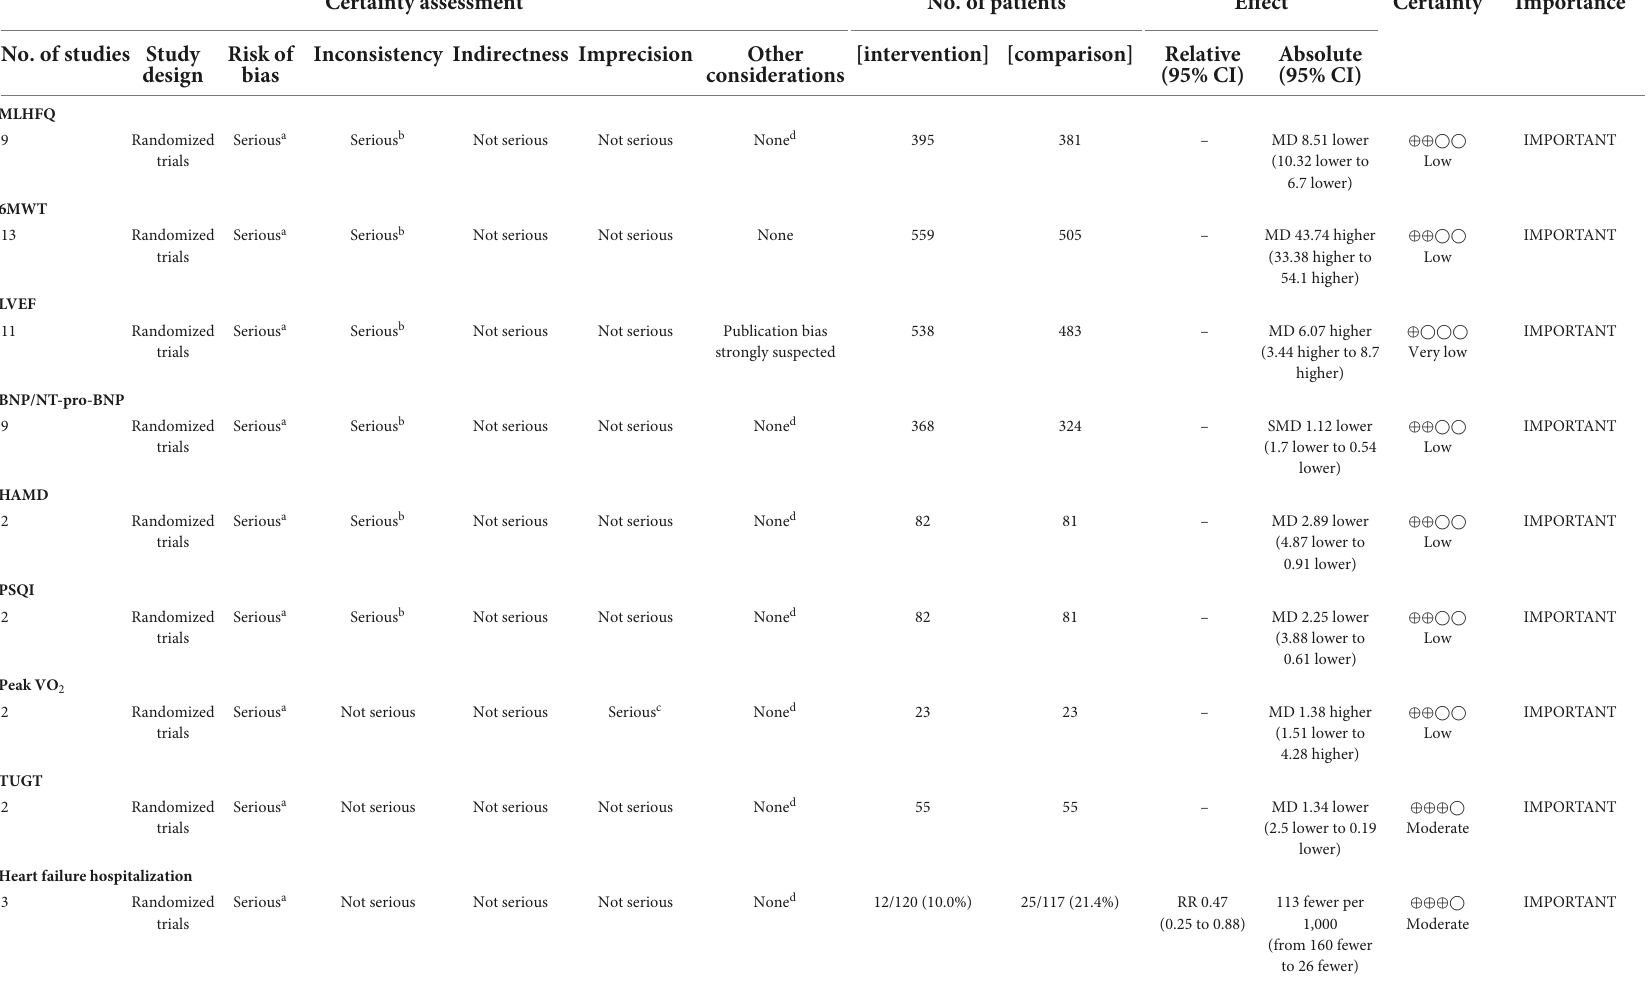
TABLE 3 The GRADE evidence profile for Tai Chi in the treatment of patients with